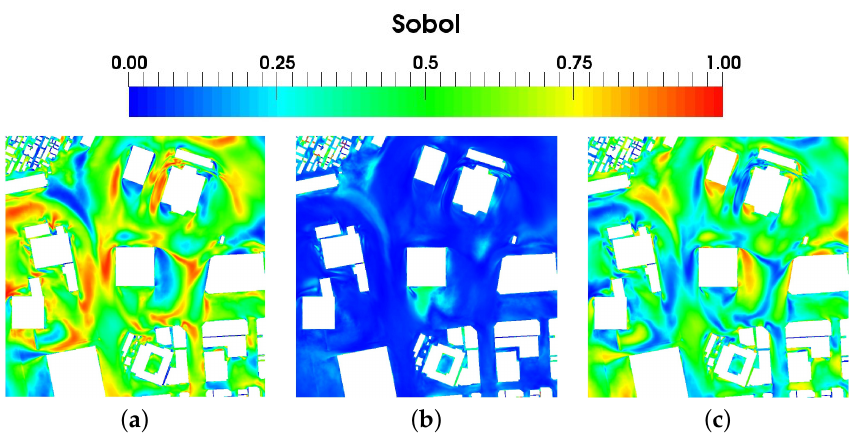
Figure 17. Sobol indices of the mean velocity computed from c-APK model for ( a ) α index, ( b ) α − θ index and ( c ) θ